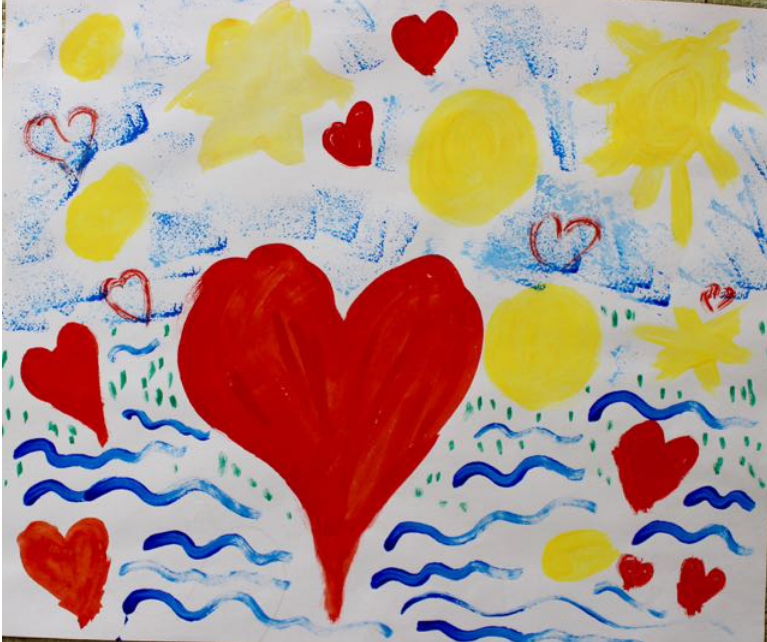
FFigigururee 5.5. CClientlient picturpicturee aftafterer trtreeatmentatment AG: The fire is out and my heart can rest in the world. It bumps around a bit on the nice waves. MW: I am no longer angry. I embrace life. Love has triumphed. I am resurrected. All the powers of nature carry me. I have faith and